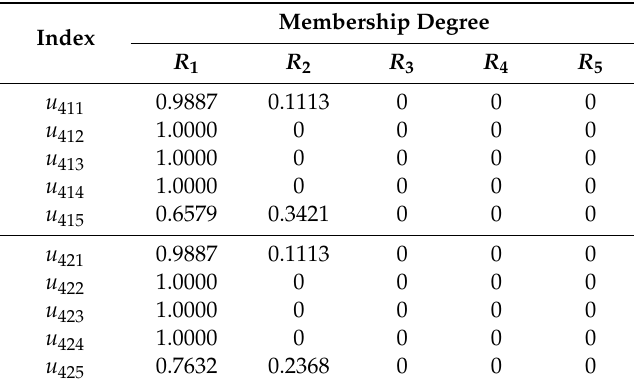
Table 12. Membership degrees of IED influencing factors (R u 4 ).